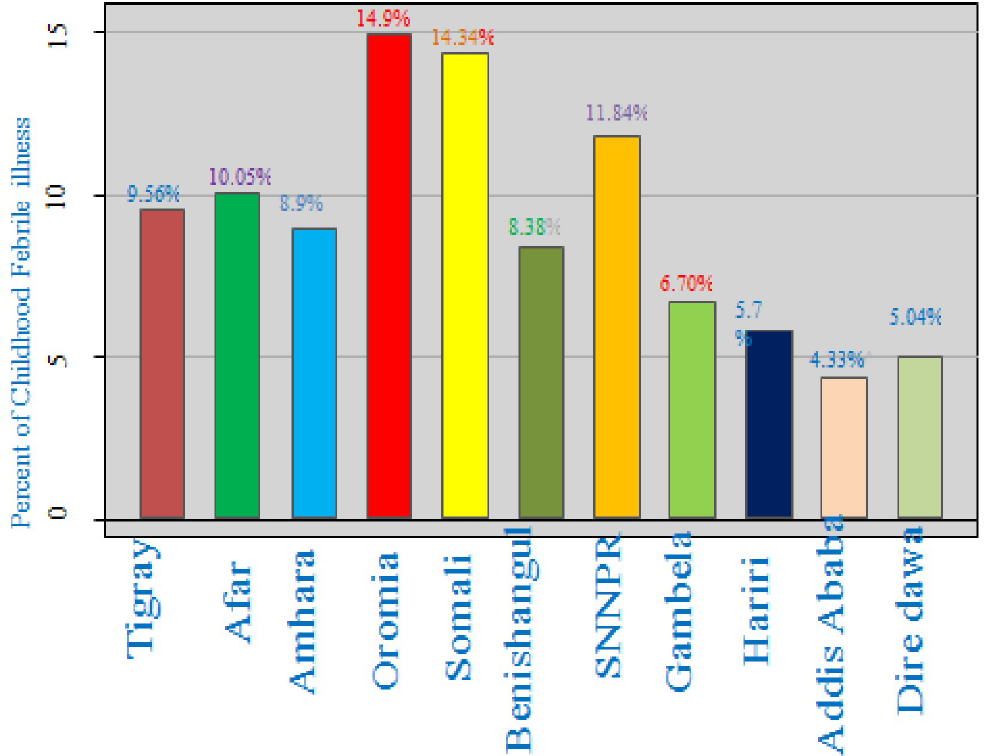
Fig 1. Prevalence of febrile illness among under-five children across regions in Ethiopia.